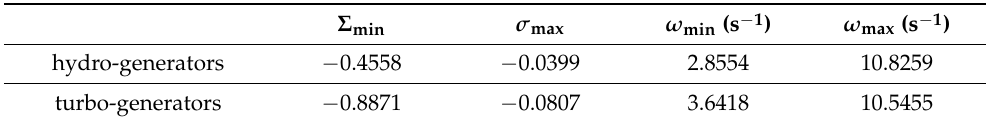
Table 3. The boundaries of real and imaginary parts of local mode eigenvalues of hydro and turbo synchronous generators of different nominal powers in an operating range from P = 0.0 pu to P = 1.2 pu and from Q = 0.0 pu to Q = 1.2 pu.